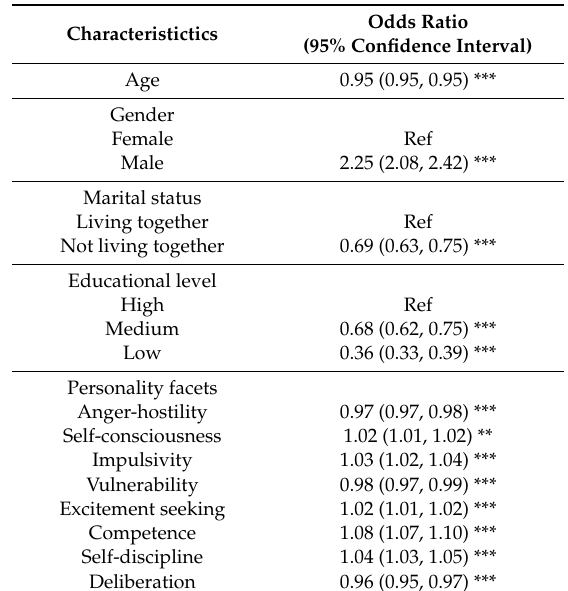
Table 3. Associations of personality and employment status 1